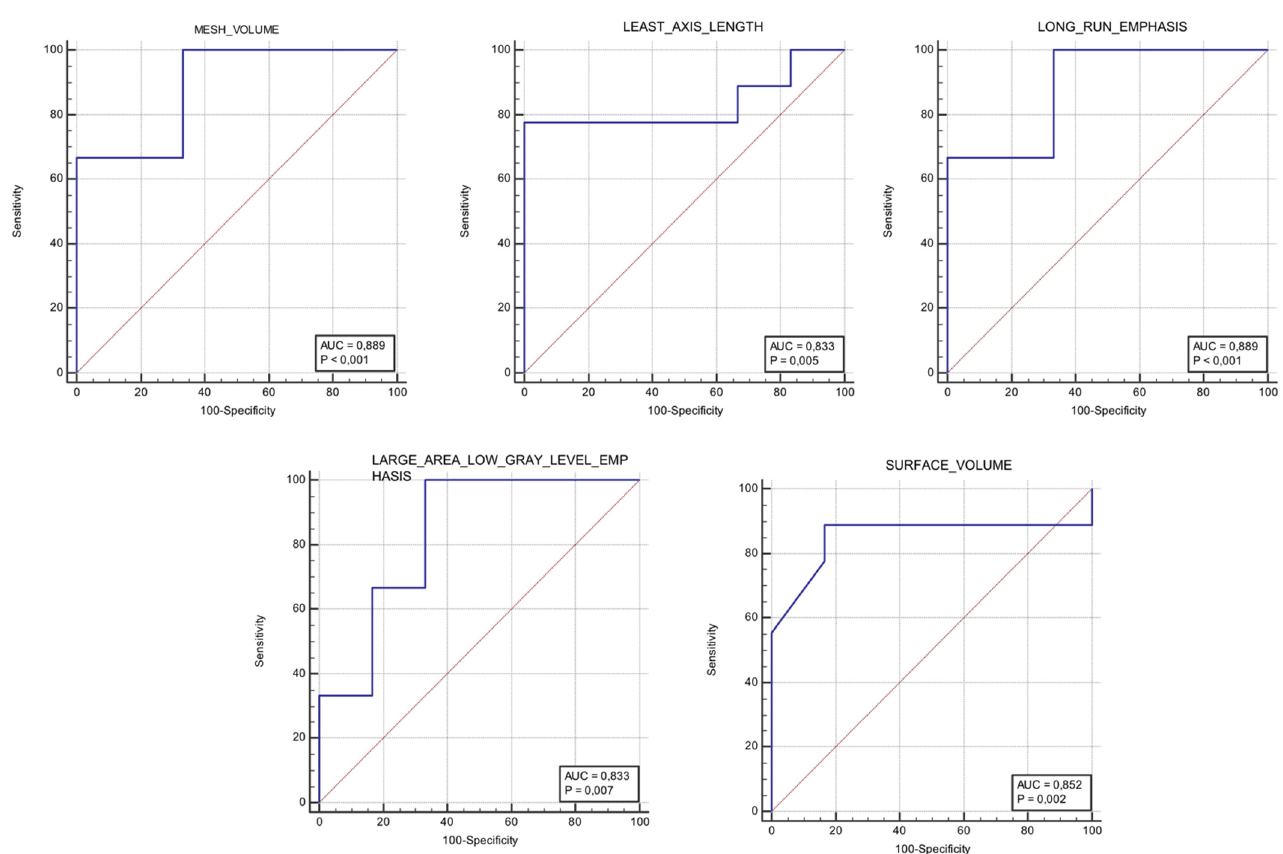
Figure 4. Significant receiver operating characteristic (ROC) curves of ∆ Radiomics obtained from the differences between pre-perioperative chemotherapy CT and post-perioperative chemotherapy CT. The area under the curve (AUC) and the p -value are reported in each ROC curve. The best AUC achieved is represented by MeshVolume and LongRunEmphasis features.